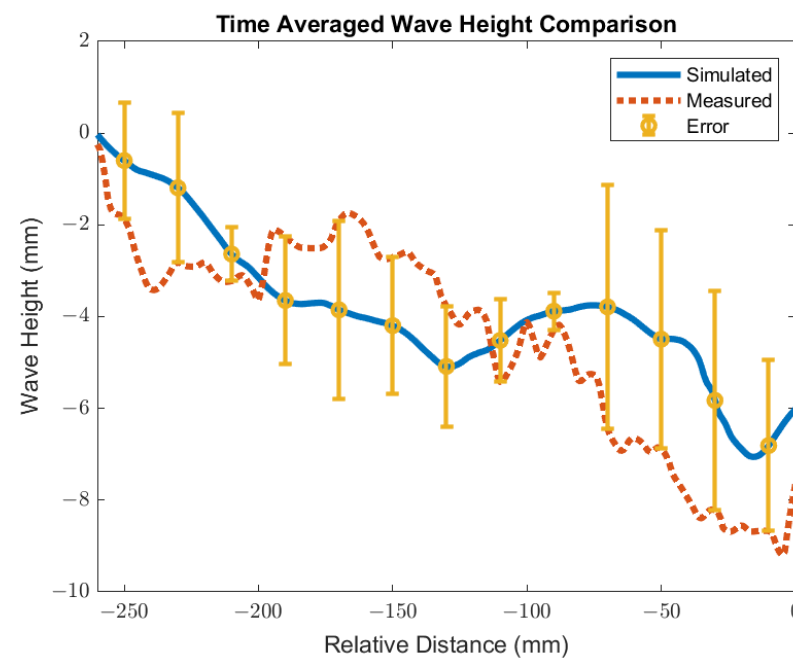
Figure 6. Time averaged wave height for validation.